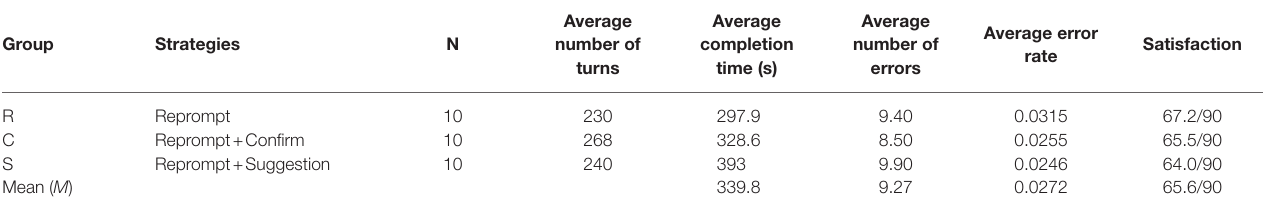
TABLE 2 | Participants’ conversational performance within three groups.